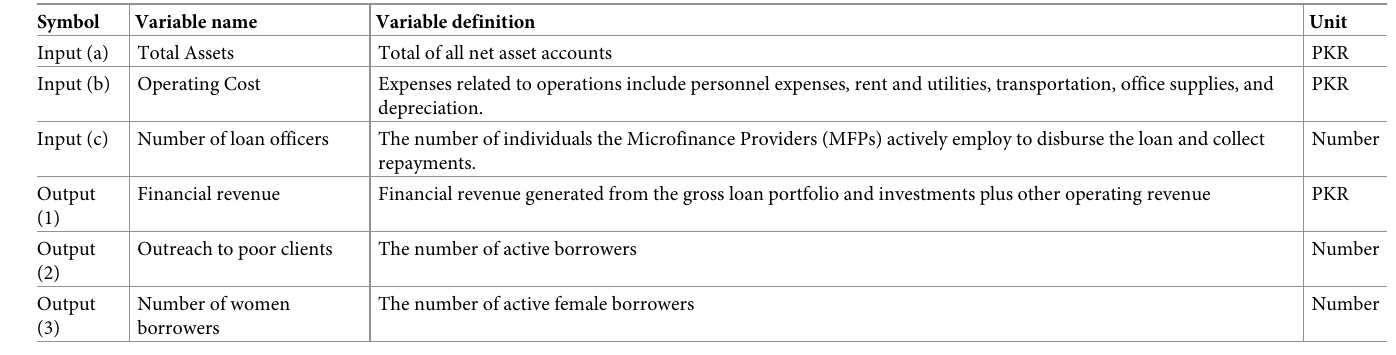
Table 1. Description of input and output